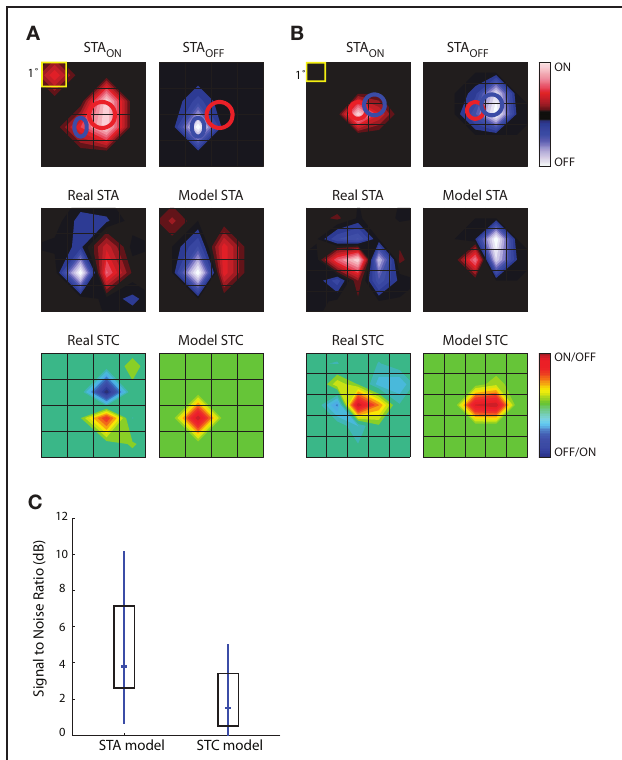
FIGURE 9 | Simulations to explore the construction of receptive fields. STAs for sparse noise are used to predict the STA and STC subunits recovered from responses to dense (Gaussian) noise. (A) Top, STAs made for bright (STA ON , left) and dark (STA OFF , right) spots, ellipses fit to the peak of each subregion are shown in both maps. Middle, STA recovered from response to dense noise (left) next to a modeled STA (right) constructed from the weighted sum of the STA ON and STA OFF shown above. Bottom, STC recovered from dense (Gaussian) noise (left) and the modeled STC (right) that was made using the weighted product of the STA ON and STA OFF . (B) Same as (A) , but for a different cell. (C) The match between the modeled STA and real STA is greater than that between the modeled STC and the actual STC, as quantified by plots of the signal to noise ratio; median (horizontal dash) and interquartile range